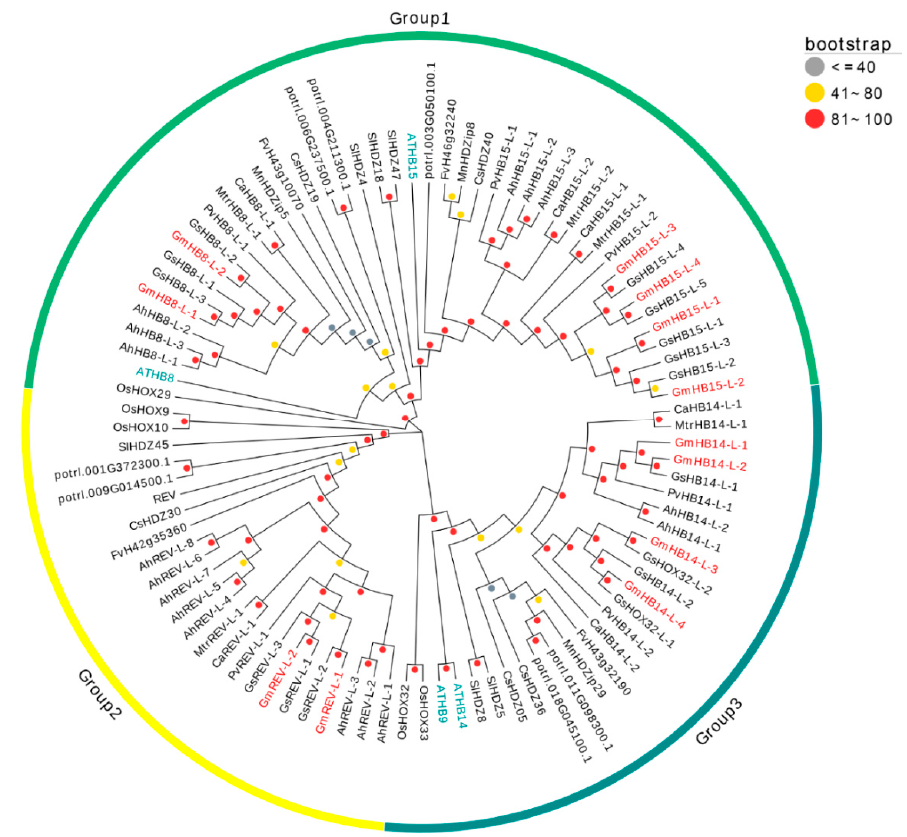
Figure 1. Phylogenetic tree of full-length HD-Zip III proteins from soybean, chickpea, peanut, kidney bean, medicago, wild soybean, strawberry, cucumber, poplar, tomato, rice, and Arabidopsis. The 90 HD-Zip III proteins from 13 plant species can be divided into three groups. The words marked in blue are Arabidopsis HD-Zip III proteins, and those marked in red are GmHD-Zip III proteins. The colors of the circles indicate physical distances: gray represents long distances, and red means short distances.